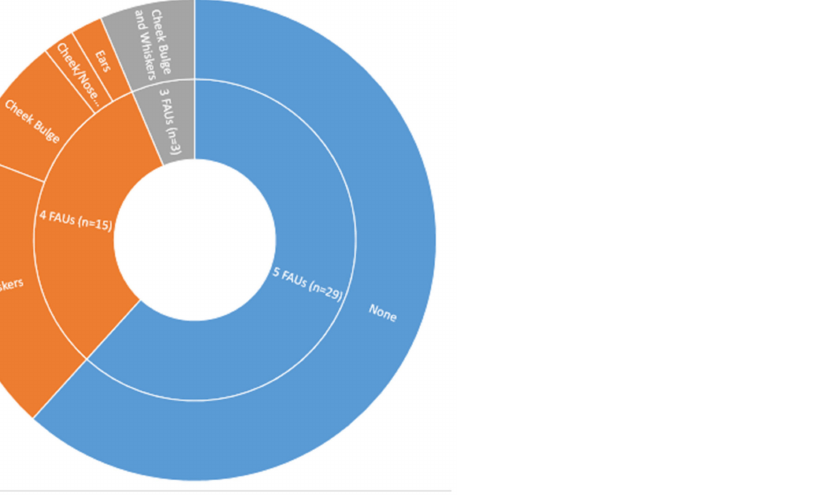
Figure 8. Facial action units (FAUs) utilised for scoring in the included studies. n represents study number. Specific action units were generally excluded as described here, although in one study two of the action units were combined.